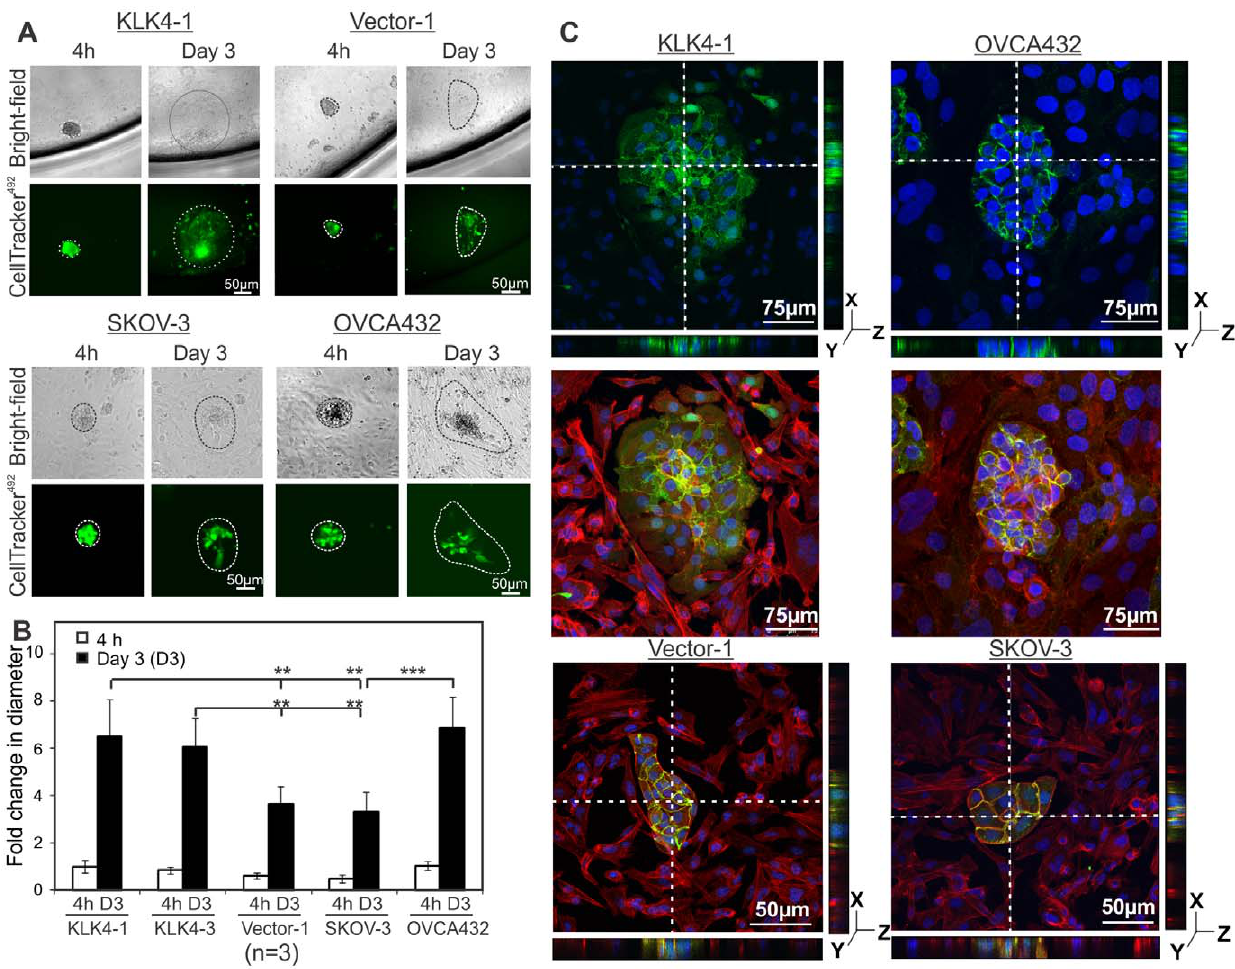
Figure 3. MCAs clear mesothelial monolayers mimicking invasion into the peritoneal membrane. A. Bright-field and fluorescence (CellTracker 492 ) images show KLK4-1, Vector-1, SKOV-3 and OVCA432 MCA (4 h and day 3) clearance of mesothelial monolayers. Discontinuous lines indicate perimeters of the spreading MCAs. B. Quantitative analysis shows the average diameter of 10 MCAs from 3 separate experiments for above cell lines at 4 h and day 3 respectively; mean 6 SE, n=3, **P , 0.01. C. IF microscopy images show mesothelial monolayer clearance of MCAs formed by KLK4-1 labeled with CellTracker 492 , Vector-1, OVCA432 and SKOV-3 cells stained with an E-cadherin antibody (green); both MCAs and mesothelial LP9 cells were stained with Phalloidin for F-actin (Alexa Flour 568, red) and DAPI for nuclei (blue) respectively; discontinuous lines indicate positions of multiple Z sections shown as right and bottom panels. For panels A and C , scale bars, 50 m m.